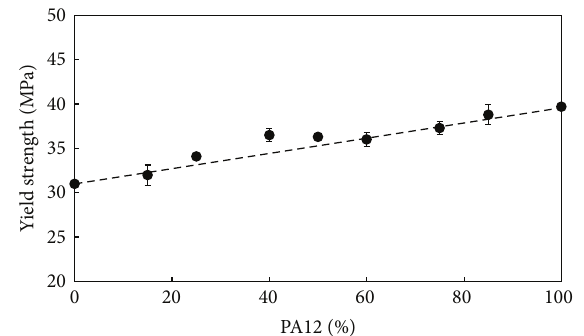
Figure 6: Yield strength of the compatibilized gPP/PA12 blends, as a function of the PA12 content.